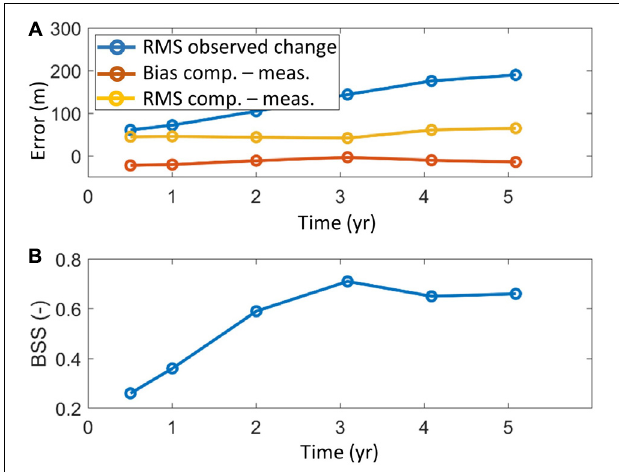
FIGURE 13 | Bias between computed and measured coastlines, rms observed change and rms error vs time (A) ; Brier Skill Score (BSS) vs. time (B) .